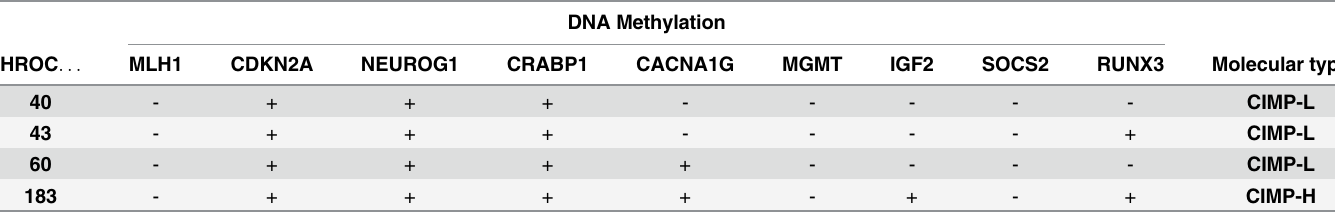
Table 3. Methylation marker and molecular classification of CIMP + cell